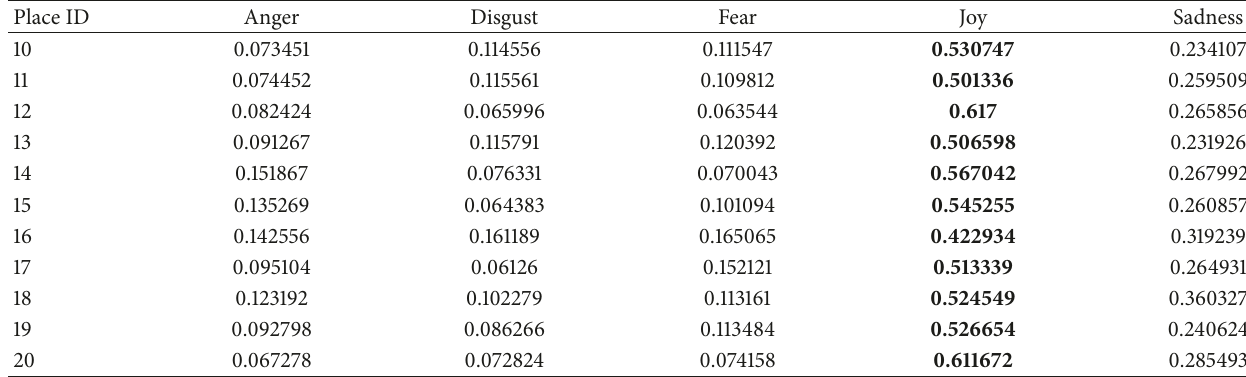
Table 1: Sample results of tone analysis created by Tone Analyzer.